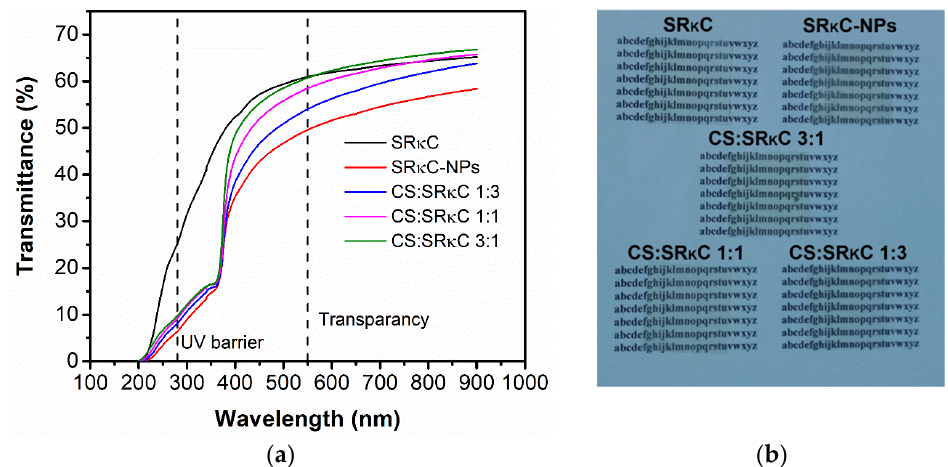
Figure 7. ( a ) UV–VIS spectra of CSRkC film with various CS concentrations in comparison with SR κ C and SR κ C − NP films; ( b ) pictures of respective bionanocomposite films.